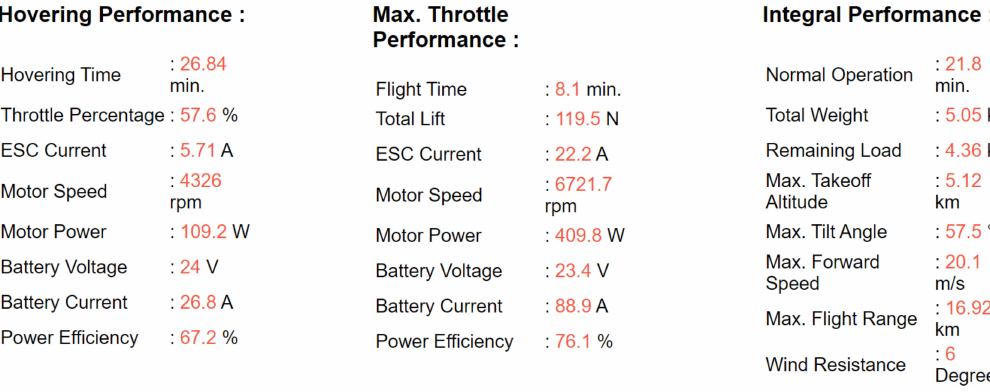
Figure 7. The performance of our proposed quadrotor.